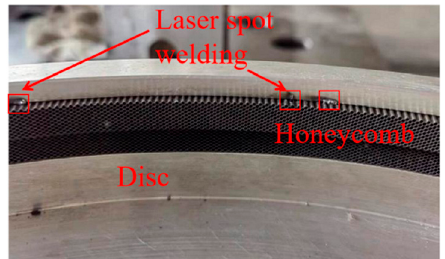
Figure 2. High-speed rotary rubbing test system.